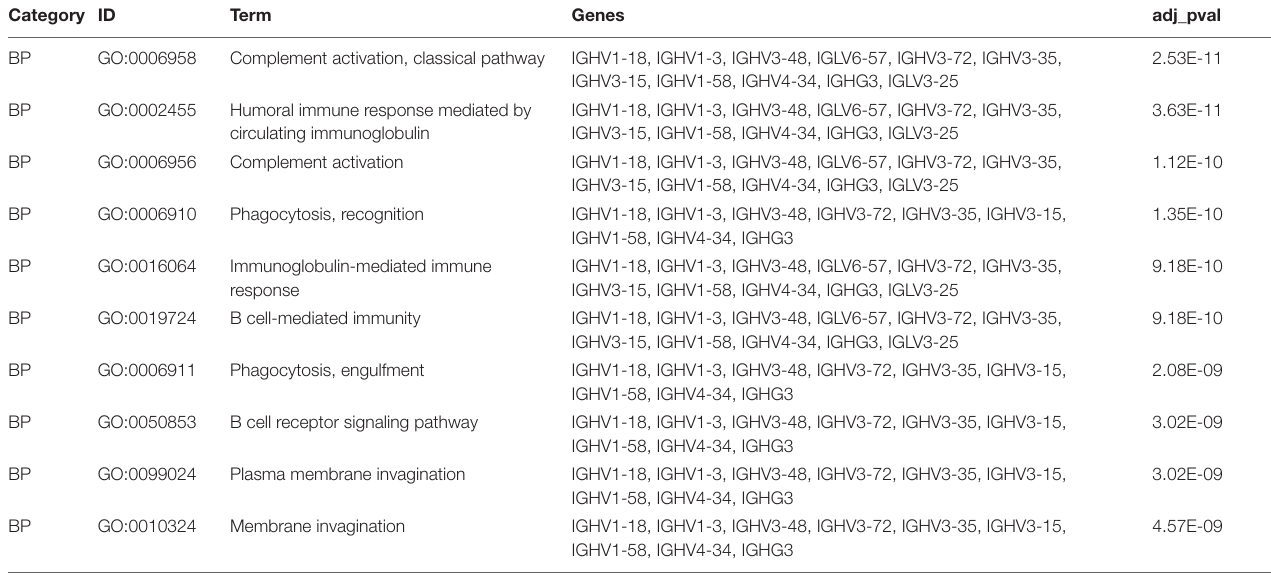
TABLE 4 | The top 10 gene ontology (GO) terms of differentially expressed genes in cluster 1.